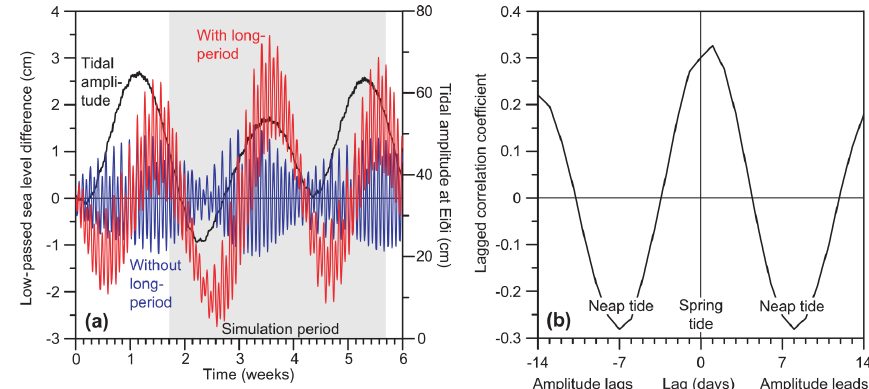
Figure 10. (a) Low-passed (25h averaged) sea level difference between Eiði and Tórshavn (Eiði minus Tórshavn) calculated from the observed amplitudes and Greenwich phase lags in Table 1 for a 6-week period starting 1 February 2013. The blue curve (left y axis) is generated by using only the five semidiurnal and diurnal constituents in the table. The red curve (left y axis) is based on all the constituents including the four long-period constituents. The black curve (right y axis) shows the tidal amplitude at Eiði defined as the standard deviation of sea level for each 25h interval. The grey-shaded area indicates the simulation period. (b) Lagged correlation coefficient between 25h averaged difference in observed sea level between Eiði and Tórshavn and the tidal amplitude in Eiði based on observed sea level (tide gauge measurements) for the 2009–2014